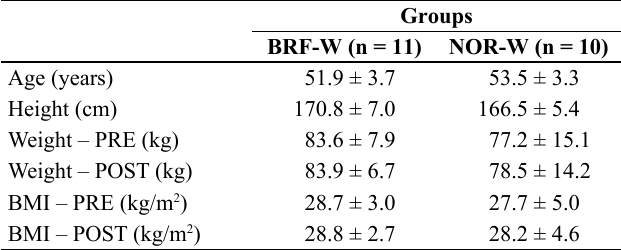
Table 1. Demographic characteristics.